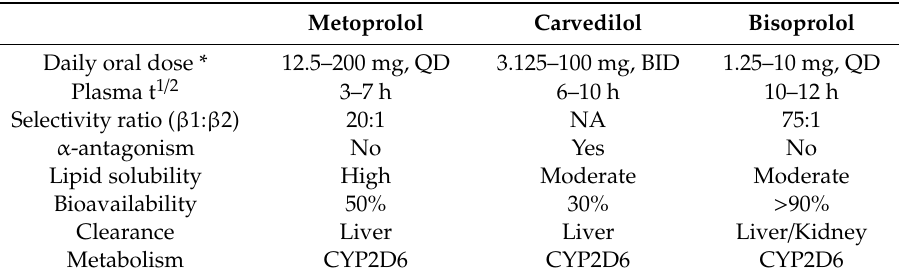
Table 1. Pharmacological properties of β